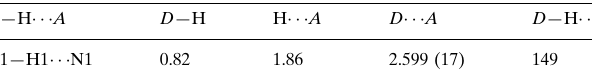
Hydrogen-bond geometry (A˚ , (cid:2)